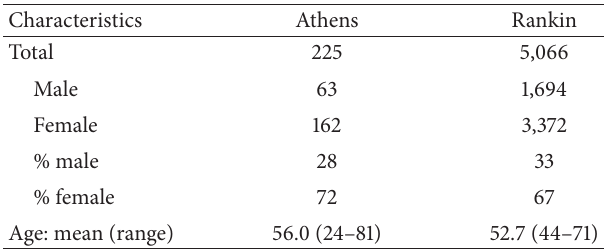
Table 1: Comparison of gender and mean age distribution in participants attending the Athens, OH, CHIP classes versus those who attended CHIP classes in the US, excluding those attending the Athens classes (Rankin et al.